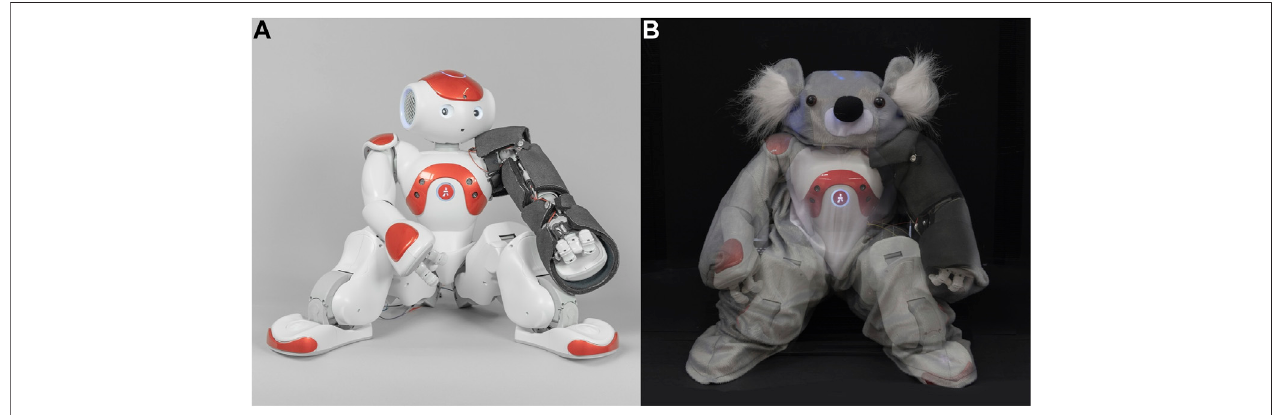
FIGURE 1 | (A) Custom tactile sensors were built from fabric and foam to wrap around the four rigid segments of NAO ’ s arm. (B) As seen in this photo-merge, the sensors are secured on top of the robot ’ s plastic exterior and are hidden underneath a soft koala suit to create the robot companion HERA.